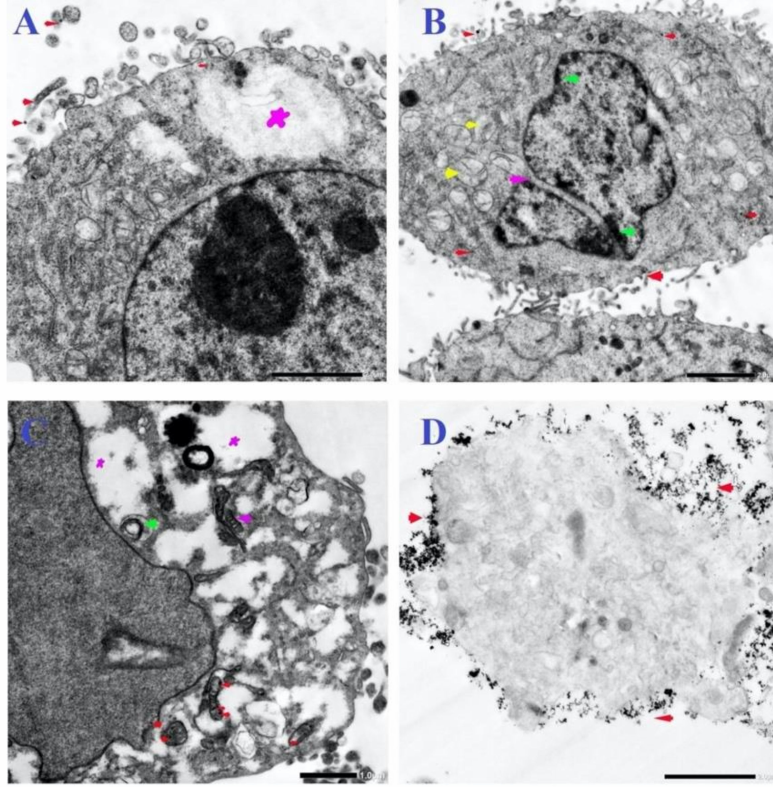
Figure 8. TEM micrographs of HCT-116 ( A-B ), MCF-7 ( C ), and HepG2 ( D ) cells treated with N-SNPs at IC50. ( A ) Cytoplasm dissolution (violet star), N-SNPs attached to membrane blebbing and microvilli and scattered in cytoplasm (red arrow). ( B ) Swollen mitochondria with damaged cristae (yellow arrow), fragmented nucleus (purple arrow) with margined chromatin (green arrow), N-SNPs attached to membrane blebs and scattered in cytoplasm (red arrow). ( C ) Cytoplasmic dissolution (violet star), autophagic vacuoles (green arrow), fragmented oval mitochondria (violet arrow), attachment of N-SNPs to mitochondria (red arrow). ( D ) Apoptotic body and attachment of NPs to plasma membrane (red arrow). Scale bar = 2 µ m ( A, B and D ) and 1 µ m ( C